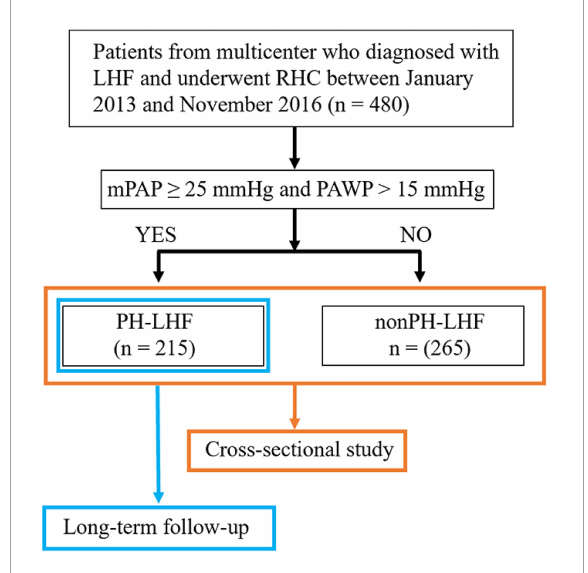
FIGURE1 The study design and flowchart for the selection of patients. LHF, left heart failure; RHC, right heart catheterization; mPAP, mean pulmonary artery pressure; PAWP, pulmonary artery wedge pressure; PH-LHF, pulmonary hypertension due to left heart